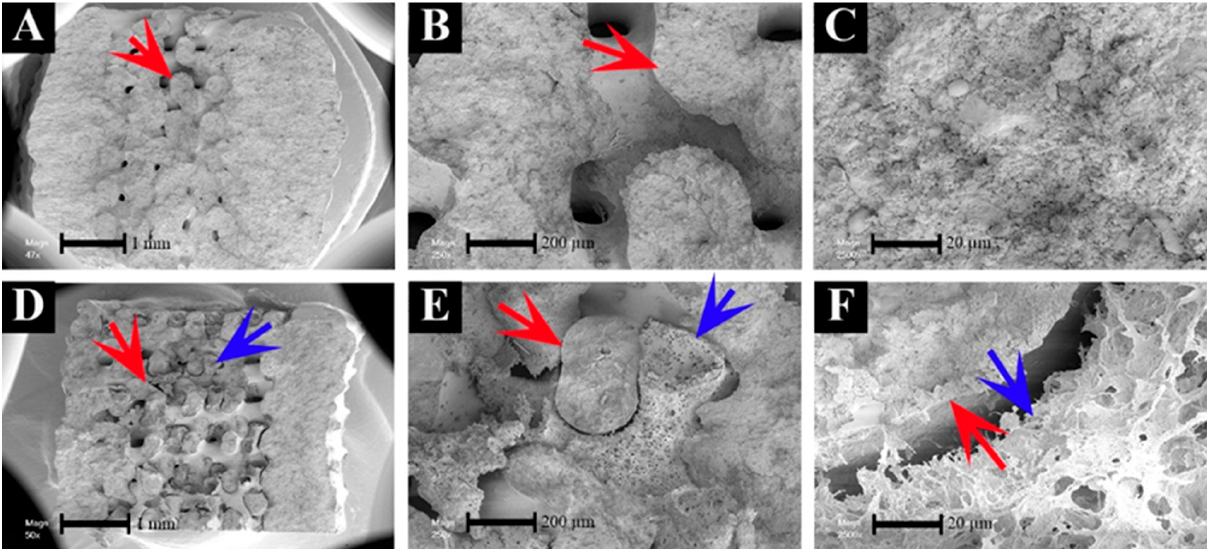
Figure 3. Scanning electron microscopy (SEM) images of CPC ( A – C ) and hybrid MCM-CPC scaf- folds( D – F ) at different magnifications (red arrows: CPC, blue arrows: MCM).